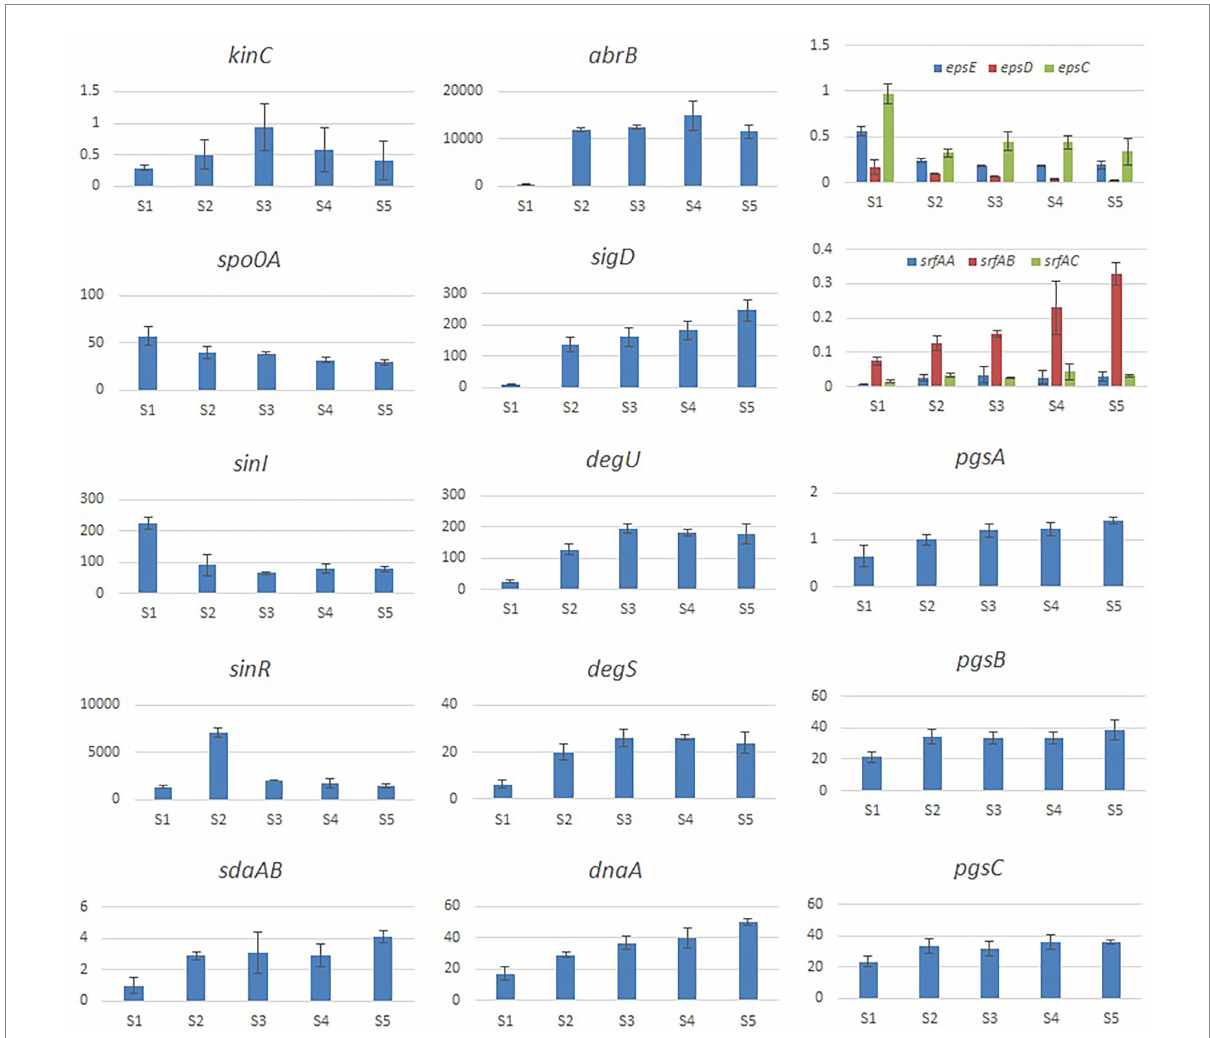
FIGURE 7 Relative expression level of the genes involved in extracellular secretion and regulation of B. subtilis 1JN2 after Cd2 + treatment. The histogram was based on the expression level in FPKM (Fragments per Kilobase of Transcript per Million Fragments Mapped)